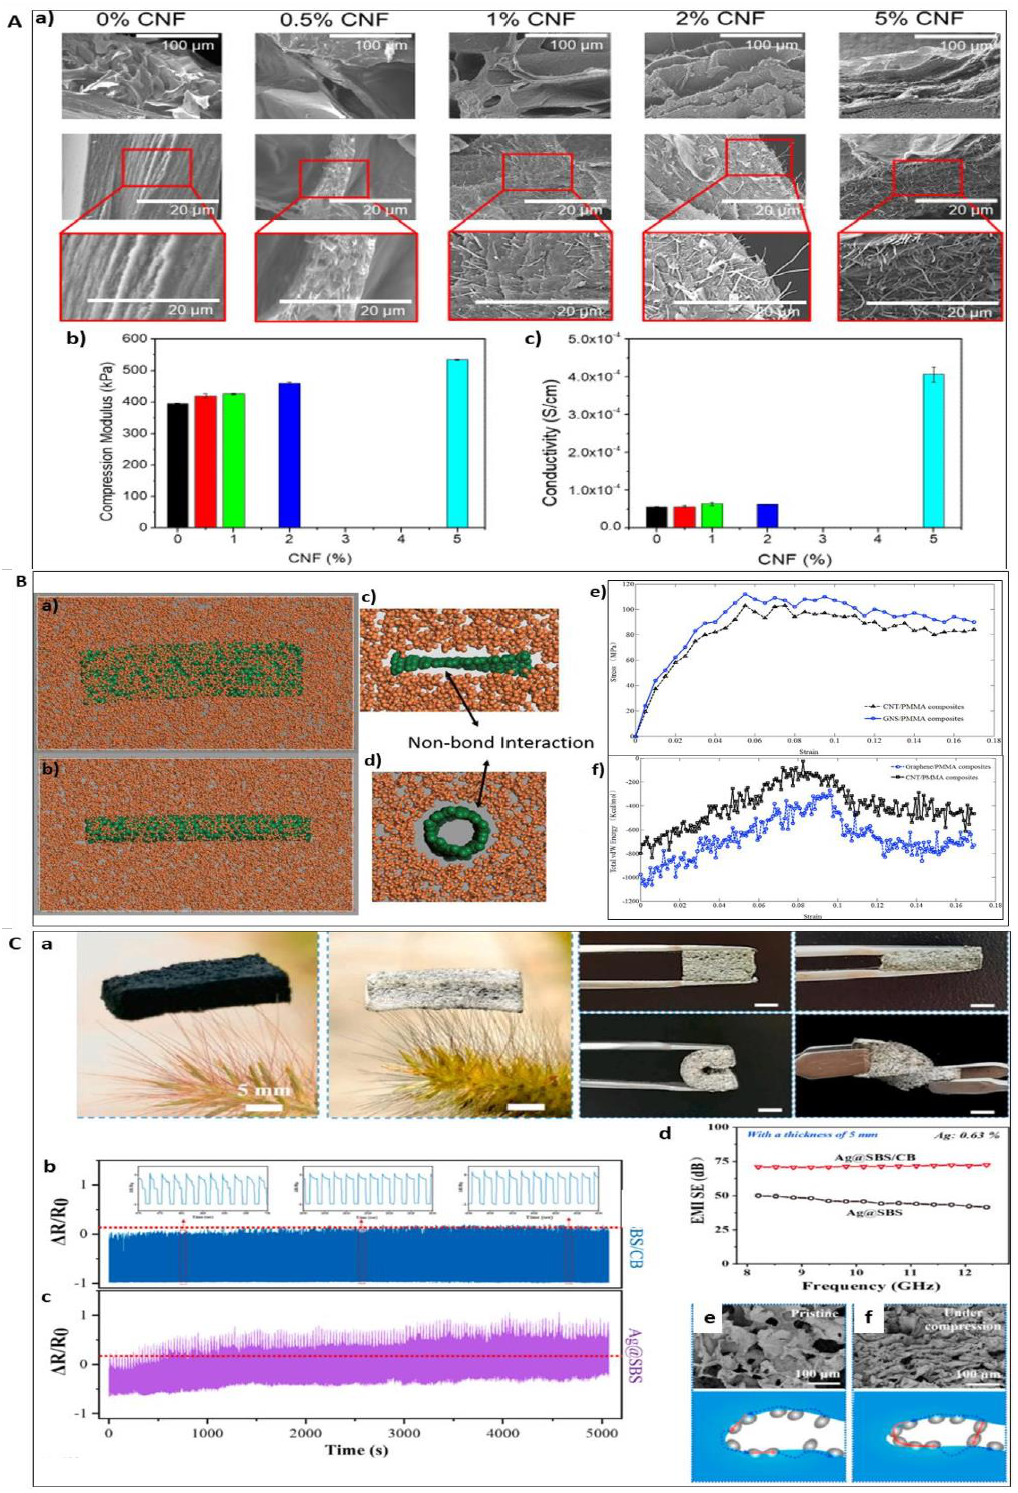
Figure 6. A) SEM images of lyophilised hydrogels with different CNF content ( a ) (Top row scale bar 100 µm, middle and bottom row 20 µm.); ( b ) Young ’ s modulus and ( c ) electrical conductivity of the samples of alginate/gelatin/CNFs hydro- gels as a function of the CNFs content, respectively. Reproduced with permission from Ref. [124]; copyright (2021), Else- vier. B) Molecular models of the: ( a ) CNT/PMMA composites, ( b ) GNS/PMMA composites, ( c ) and ( d ) cross section views of the interfacial interactions between the nano-reinforcements and PMMA matrices. The PMMA matrices and nano-rein- forcements are presented by the colors of orange and green, respectively. ( e ) The strain – stress curves of the CNT, GNS/PMMA composites. ( f ) Total vdW energy of the CNTs, GNS/PMMA composites during the tensile processes.